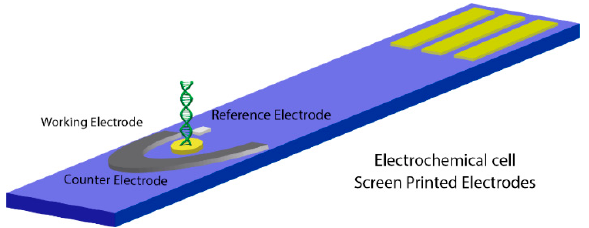
Figure 1. Schematic drawing of the electrochemical